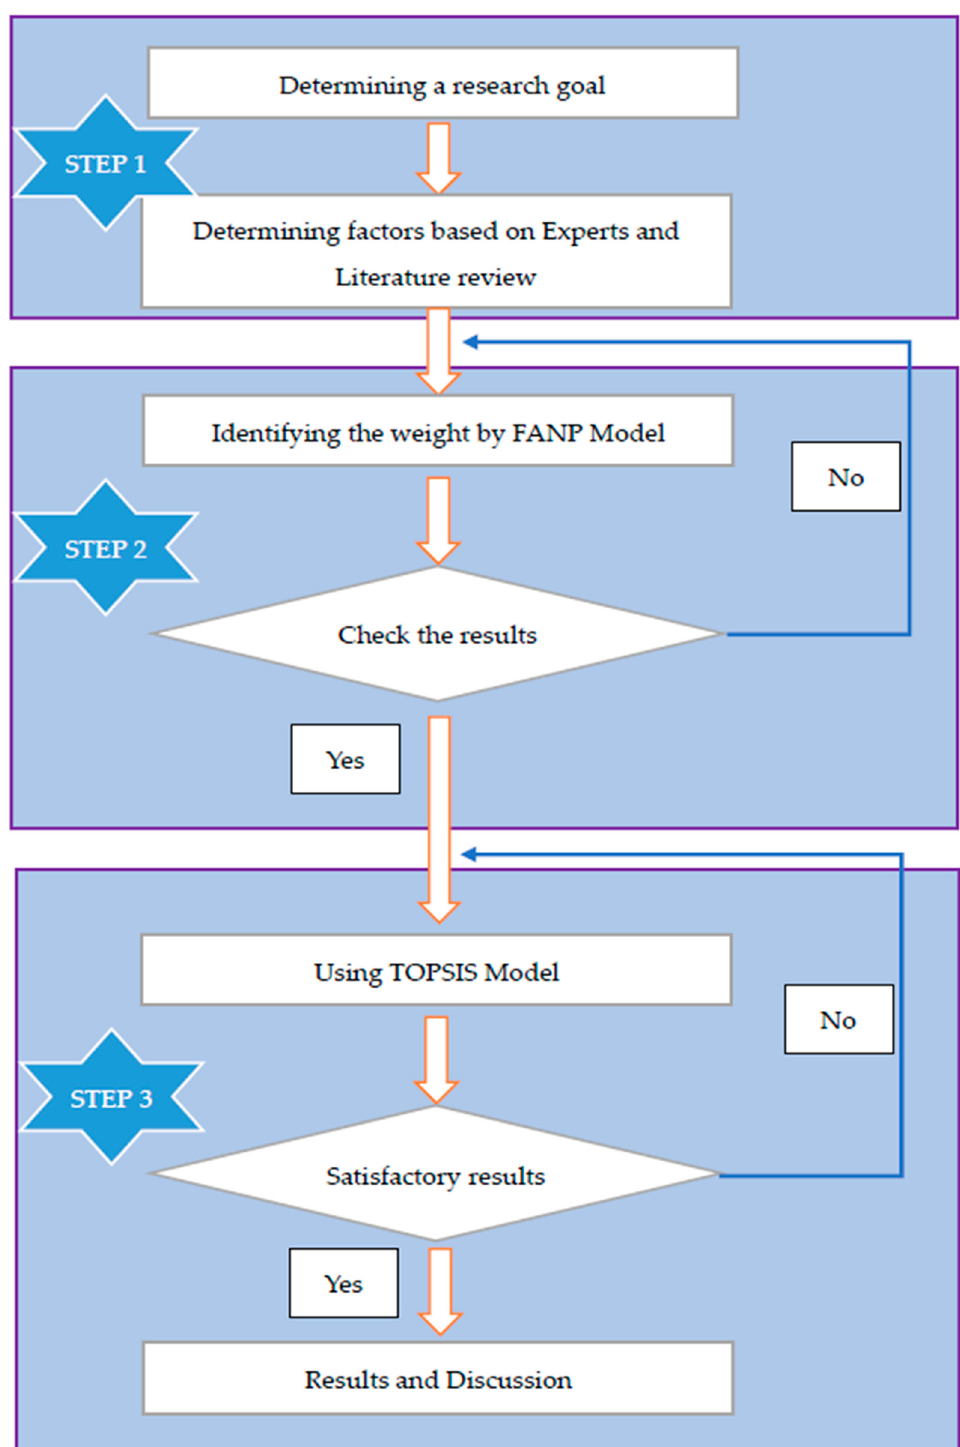
Figure 1. Research Figure 1. Research methodology.